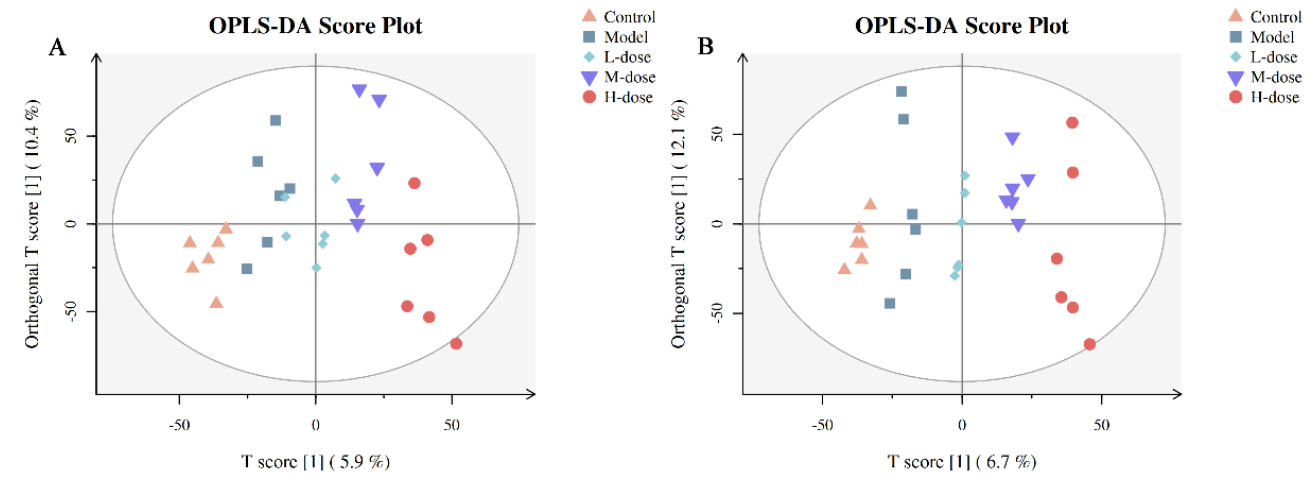
Figure 11. The OPLS-DA scores of the control, model, L-dose, M-dose and H-dose groups are based on the serum metabolite curve in positive and negative ion modes. ( A ) Positive ion mode; ( B ) Negative ion mode.